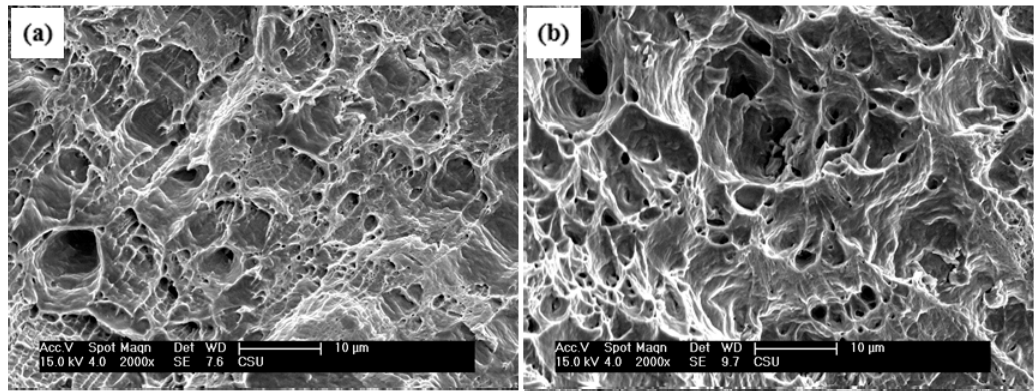
Figure 11. SEM images of the fracture appearance: ( a ) base metal (BM); and ( b ) as-welded alloy.